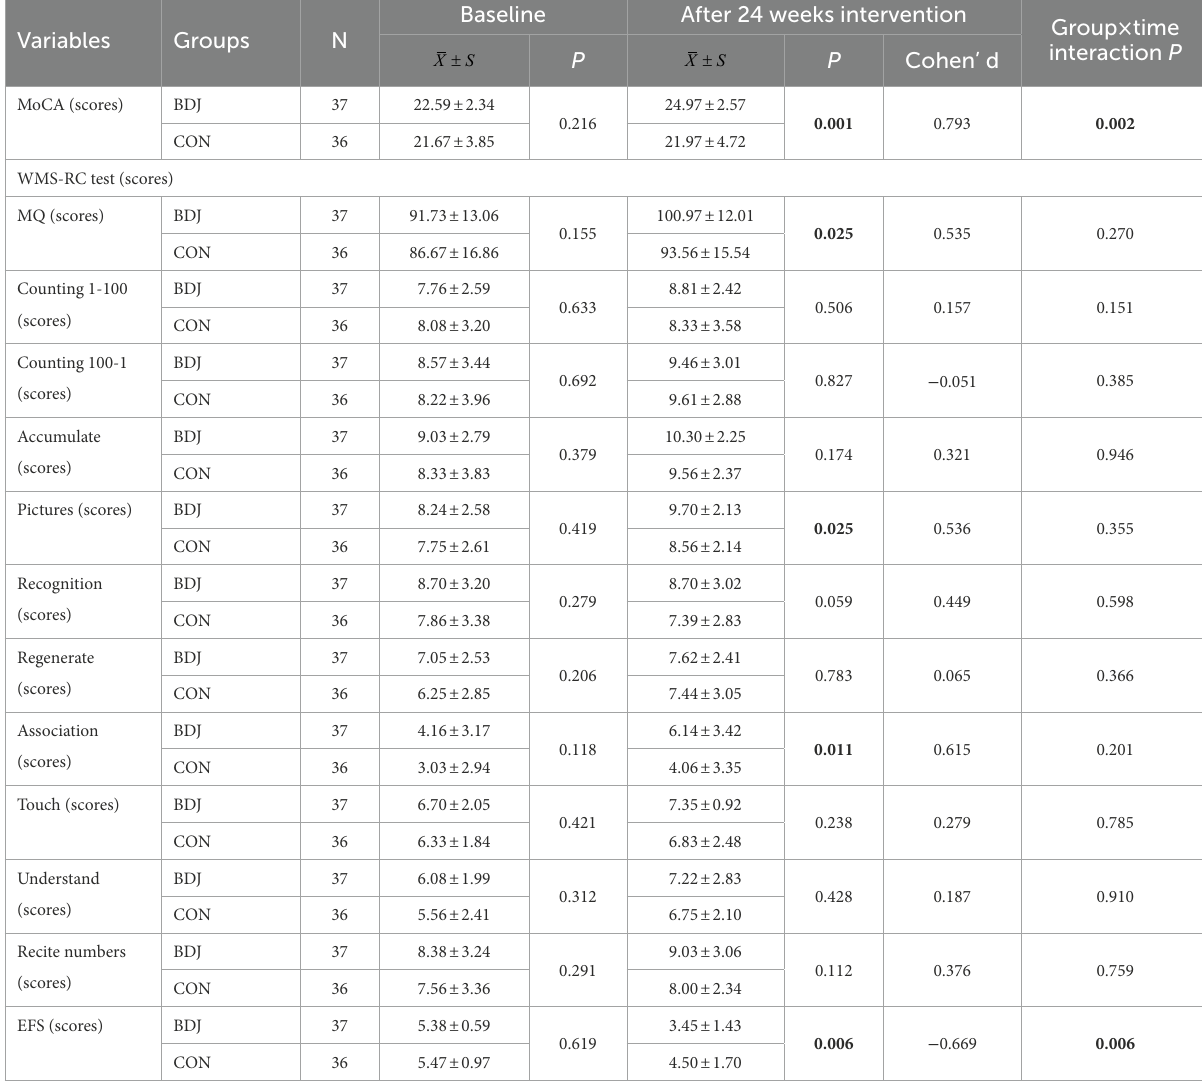
TABLE 3 Comparison of cognitive ability and physical frailty between groups at baseline and after 24 weeks intervention.